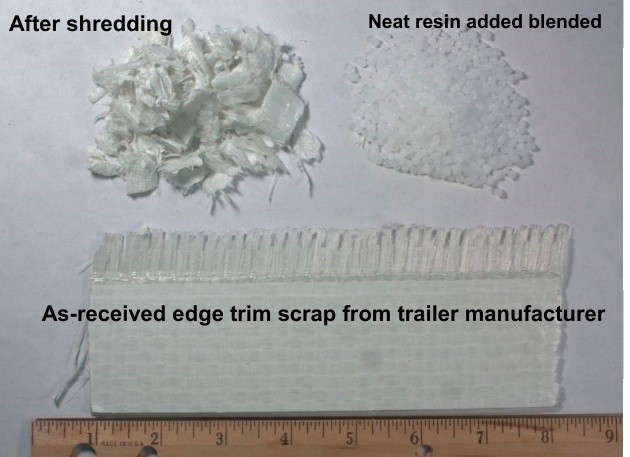
Figure 1. As-received edge trim scrap from trailer manufacture and material after shredding. Neat virgin resin is blended in limited quantities to assist in flow molding. Table 1. Summary of scrap PP-GF material in combination with virgin PP.